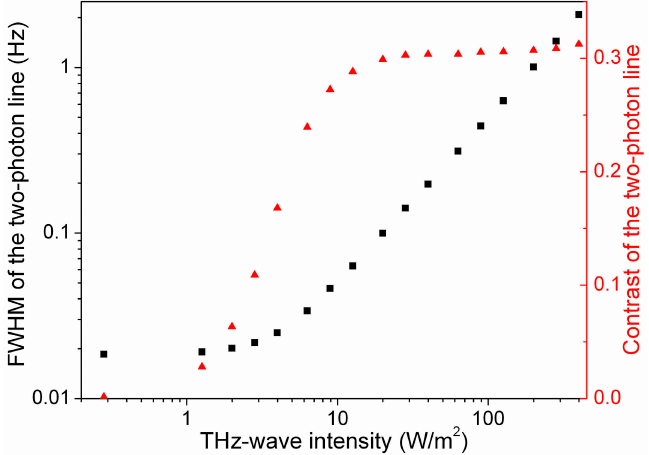
Figure 5. Dependence of the FWHM linewidth of the two-photon rotational line on the THz-wave power (black squares, left-axis). Dependence of the contrast of the two-photon rotational line with the THz-wave power (red triangles, right-axis).